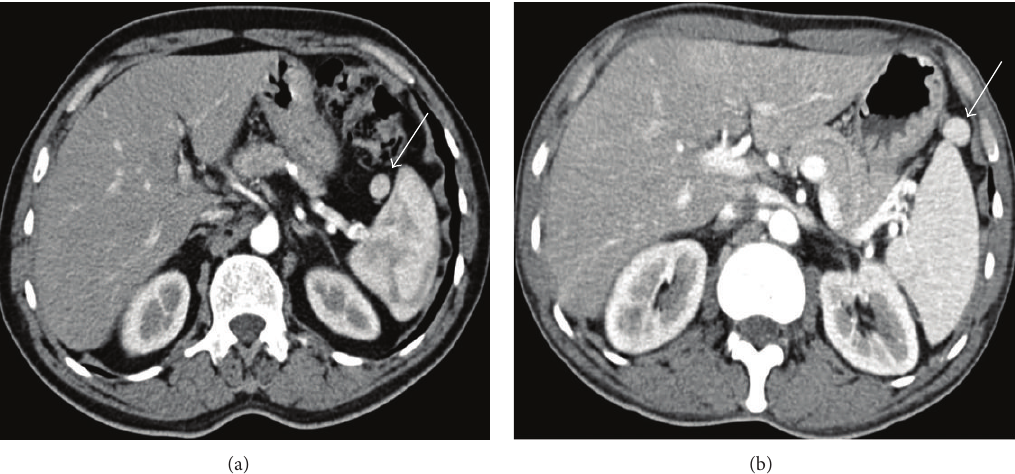
Figure 14: Axial contrast enhanced CT images (a), (b) of a 54-year-old male patient show wandering accessory spleen (arrow) anterior to the spleen which is at different locations in consecutive